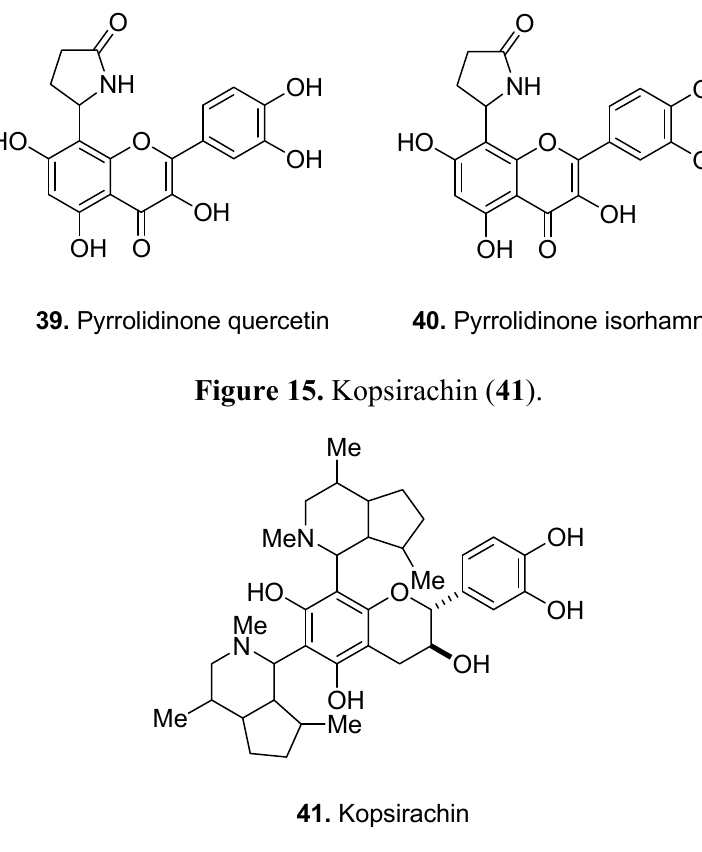
Figure 14. Pyrrolidinone quercetin ( 39 ) and pyrrolidinone isorhamnetin ( 40 ).